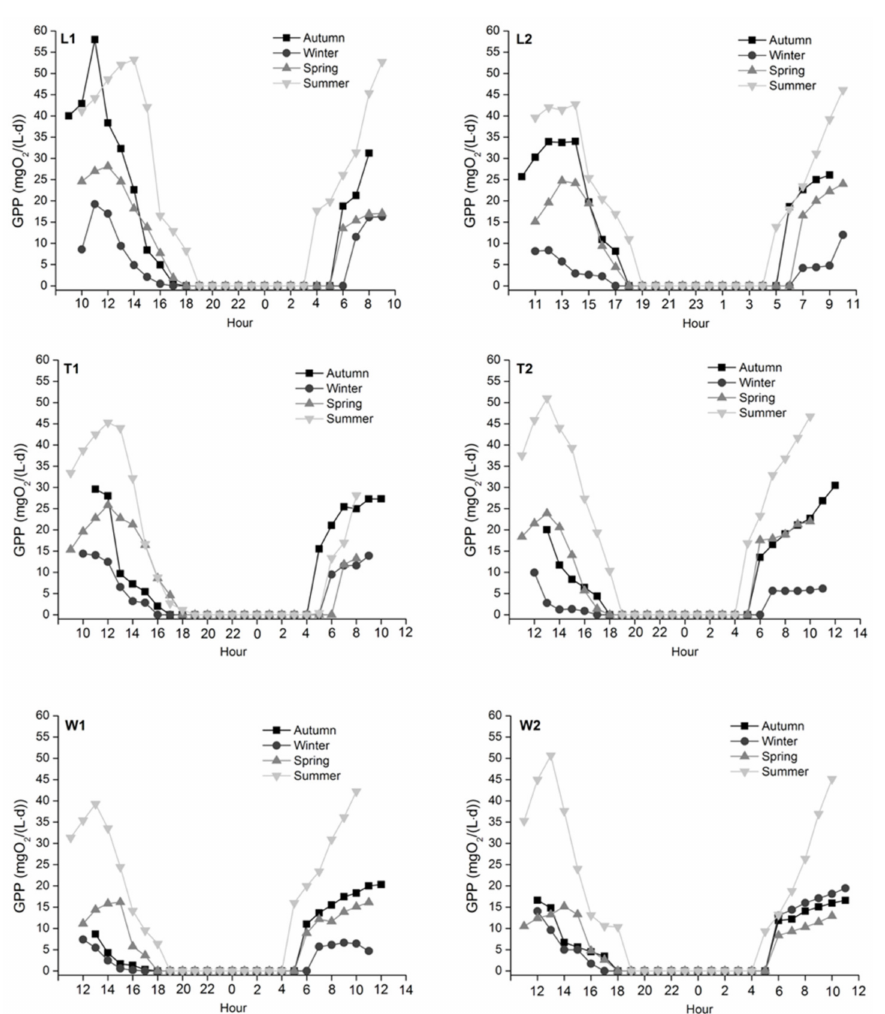
Figure 6. Diurnal variations of GPP in the four seasons across study sites. GPP dropped from the peak to 0 at night and increased from sunrise. The minimum mean GPP appeared in winter when GPP decreased from noon; The maximum mean GPP appeared in summer when GPP peaked between 1 and 3